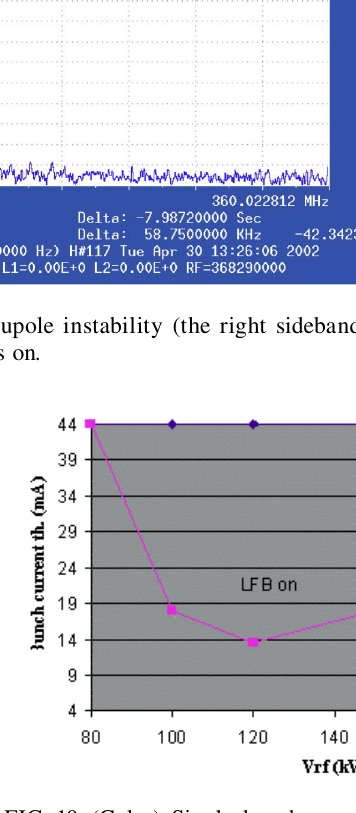
FIG. 10. (Color) Single bunch q -pole threshold ( 09 = 13 = 2001 , note: 44 mA (cid:5) no